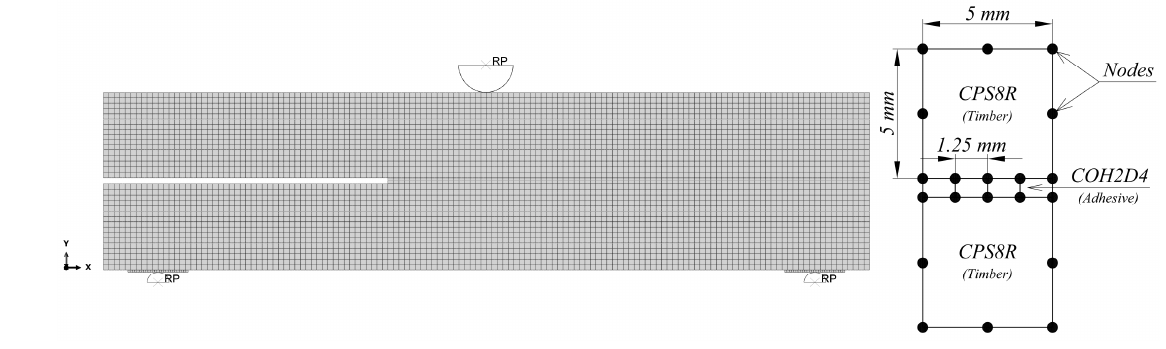
Figure 8. Meshed model and elements description.